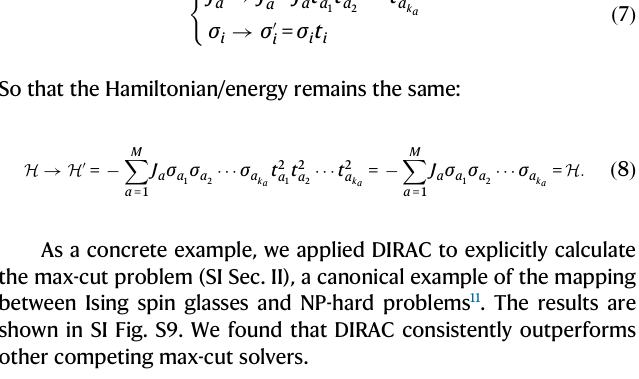
each result of SA and DIRAC-SA is calculated using 5000 initial con fi gurations, the curves of SA and DIRAC-SA actually consist of only four scatter points. Note that here the presented ground state energies reached by our PT implementation are different from the one found in the literature. For example, Ref. 51 reported an average energy density e 0 = − 1.6981 (PT) for the 3D-10 ( D =3, L =10) system, while our PT only reached an average e 0 = − 1.6707 ( f )). This is simply because different number of initial con fi gurations ( n initial ) were used. In Ref. 51 , the authors used n initial =3.2×10 7 initial con fi gurations to reach e 0 = − 1.6981, while we only used n initial =2×10 4 initial con fi gurations (i.e., fewer than one thousandth oftheir n initial ) to reach e 0 = − 1.6707. We know that for those annealing methods, the more initial con fi gurations we explored, the more potential to reach a lower